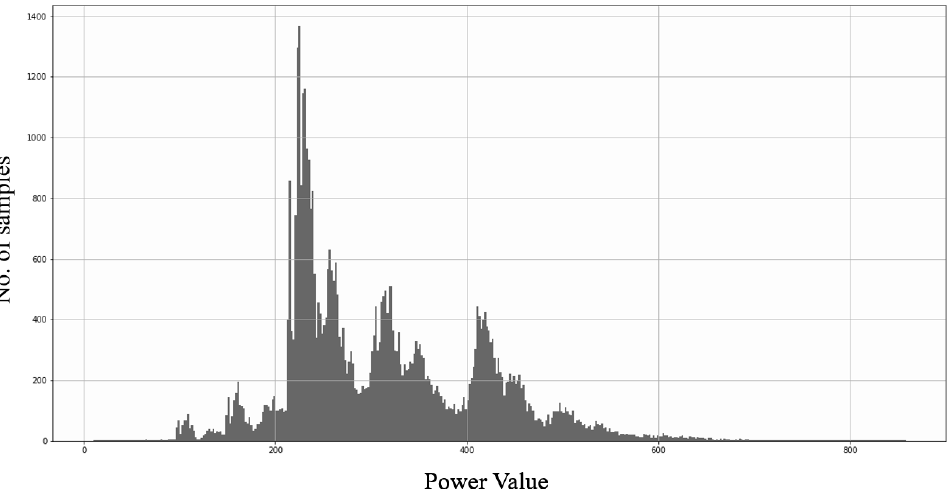
Figure 11. Distribution of power values before applying